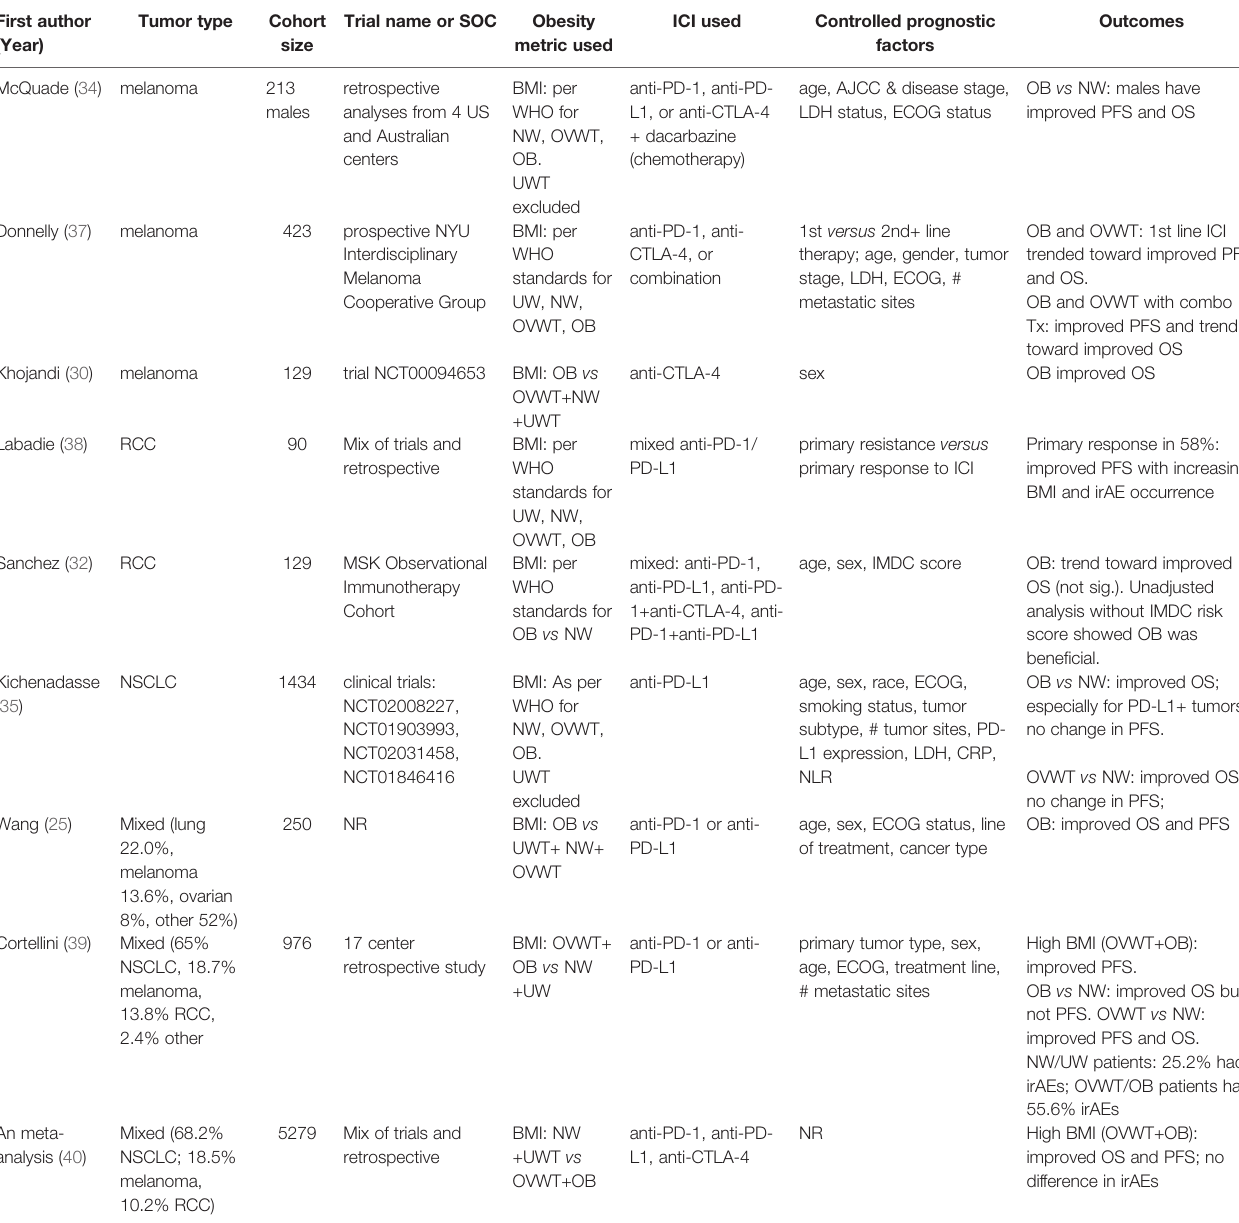
TABLE 1 | Studies supporting the obesity paradox for cancer immunotherapy